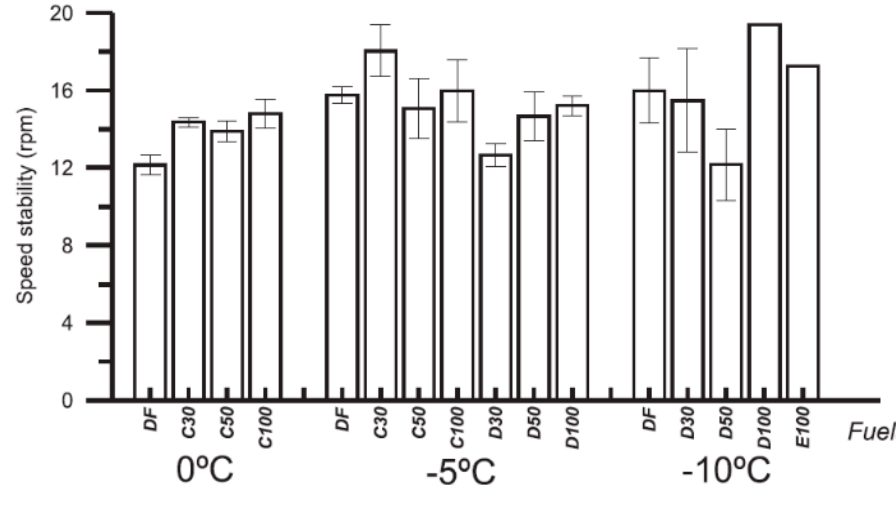
Figure 10. Biodiesel blends’ effect on speed stability [50].